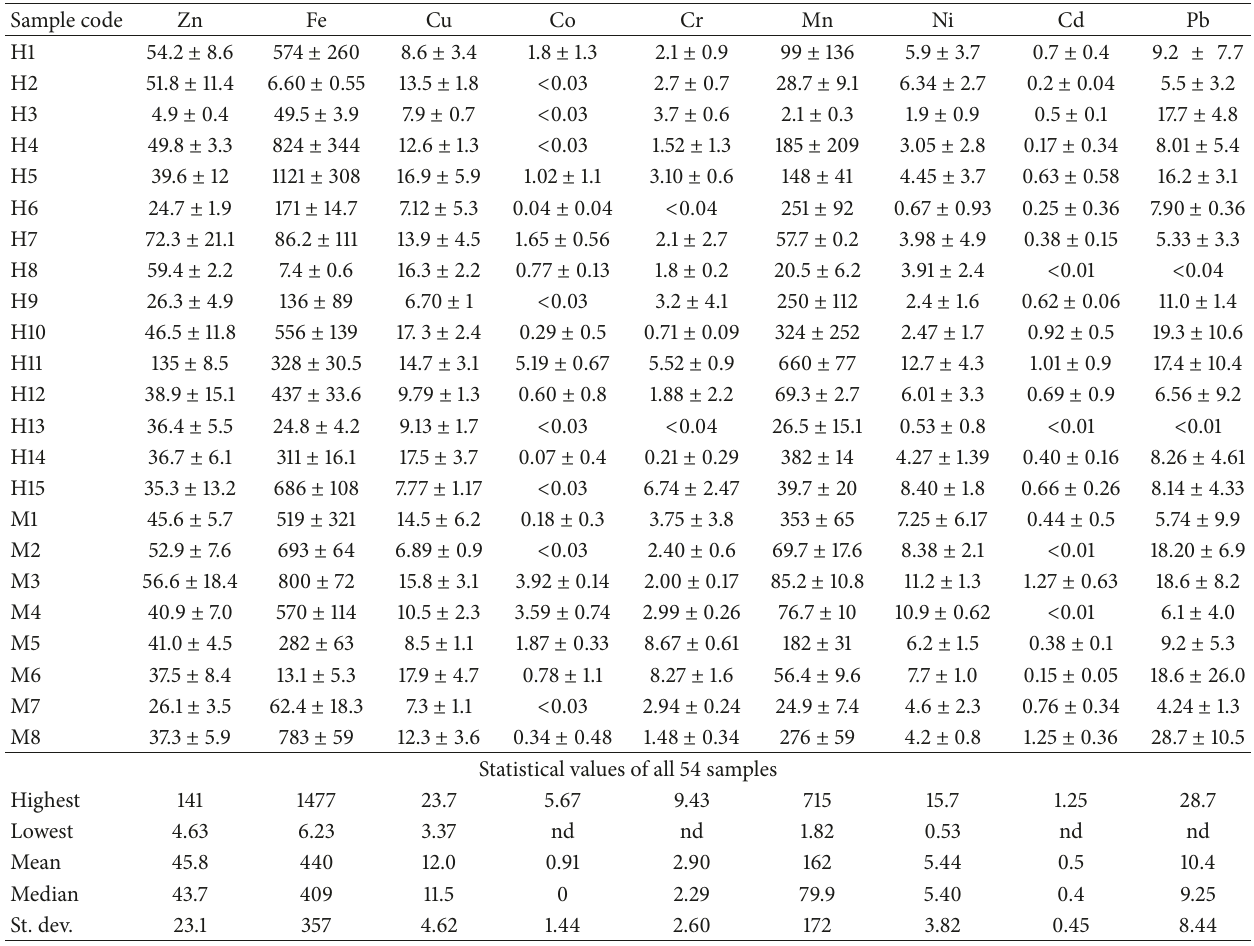
Table 3: The average contents of heavy metals (mg/kg) in the tested raw medicinal herbal samples. Sample code